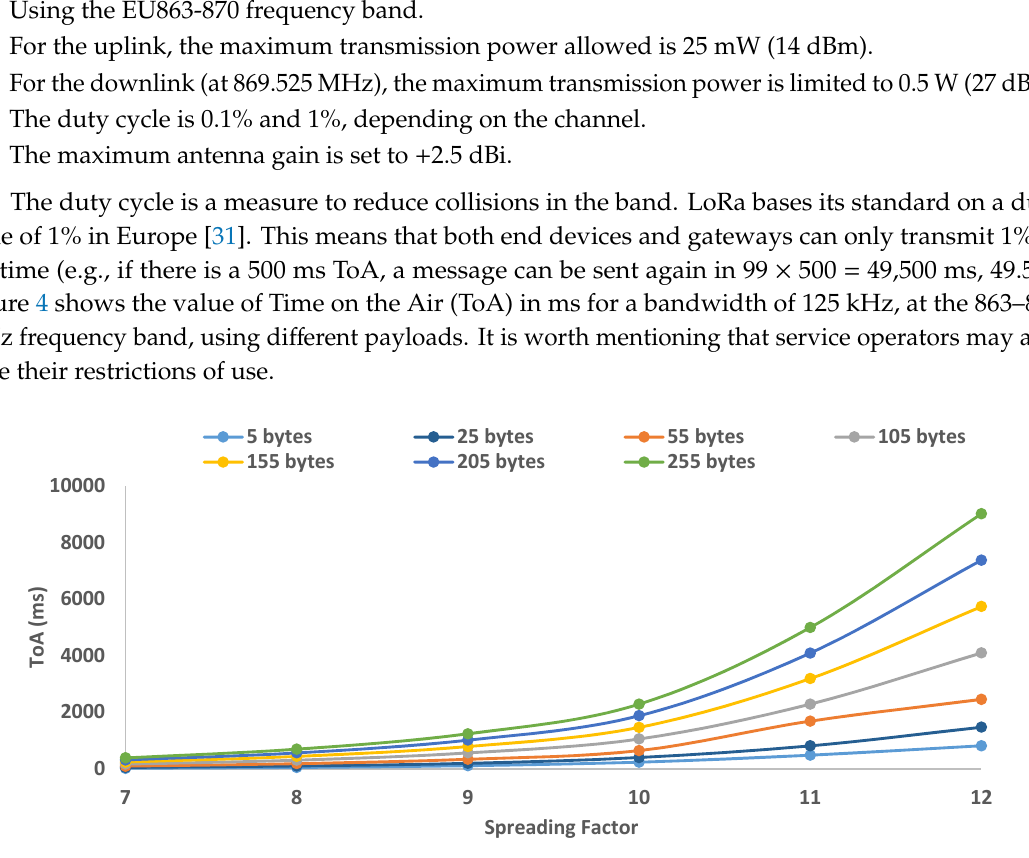
Figure 4. ToA (in ms) for different SF using a bandwidth of 125 kHz.